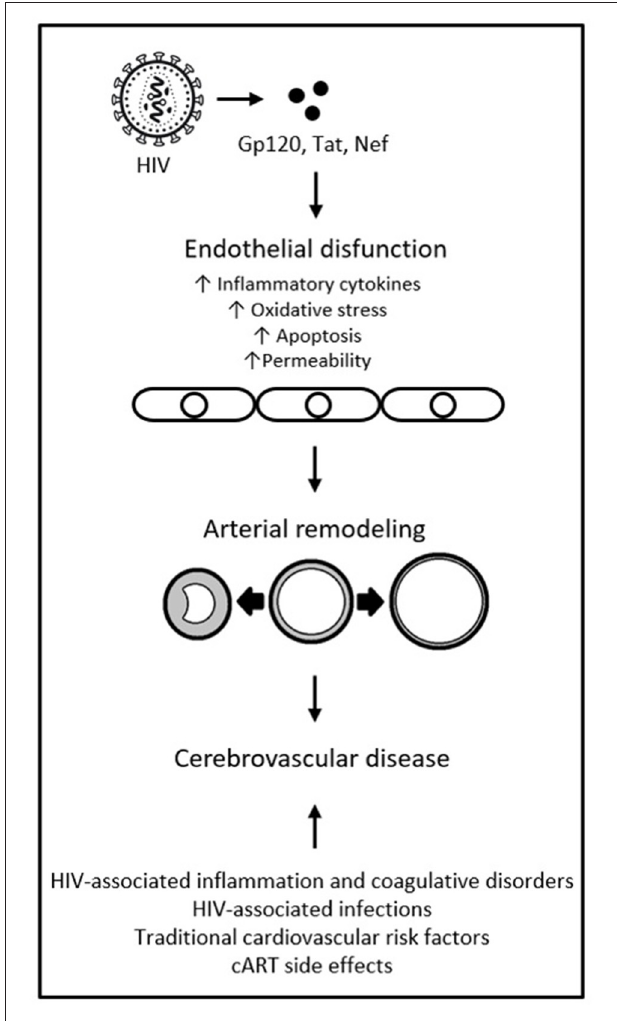
FIGURE 1 | HIV-coded proteins as a cause of endothelial dysfunction and arterial remodeling. Adapted from “HIV proteins and endothelial